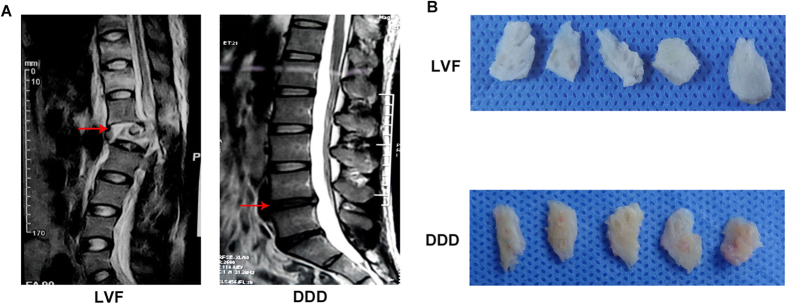
Representative MRIs and CEP samples.(A) MRI scans of spines with LVF and DDD. Featured left is a patient with lumbar LVF undergoing posterior discectomy, spinal fusion, decompression, and stability within 24 hours of trauma. This patient had no formerly documented clinical history of low back pain (LBP). Featured right is a patient with DDD undergoing discectomy and intervertebral fusion surgery. The red arrow indicates the position of the experimental material. (B) CEP samples carefully isolated from IVD tissue with a scalpel.